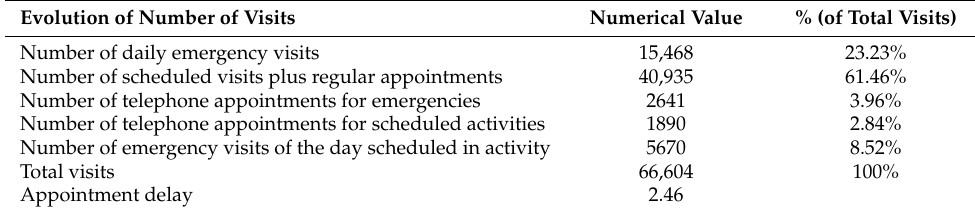
Table 3. 2019 measurement